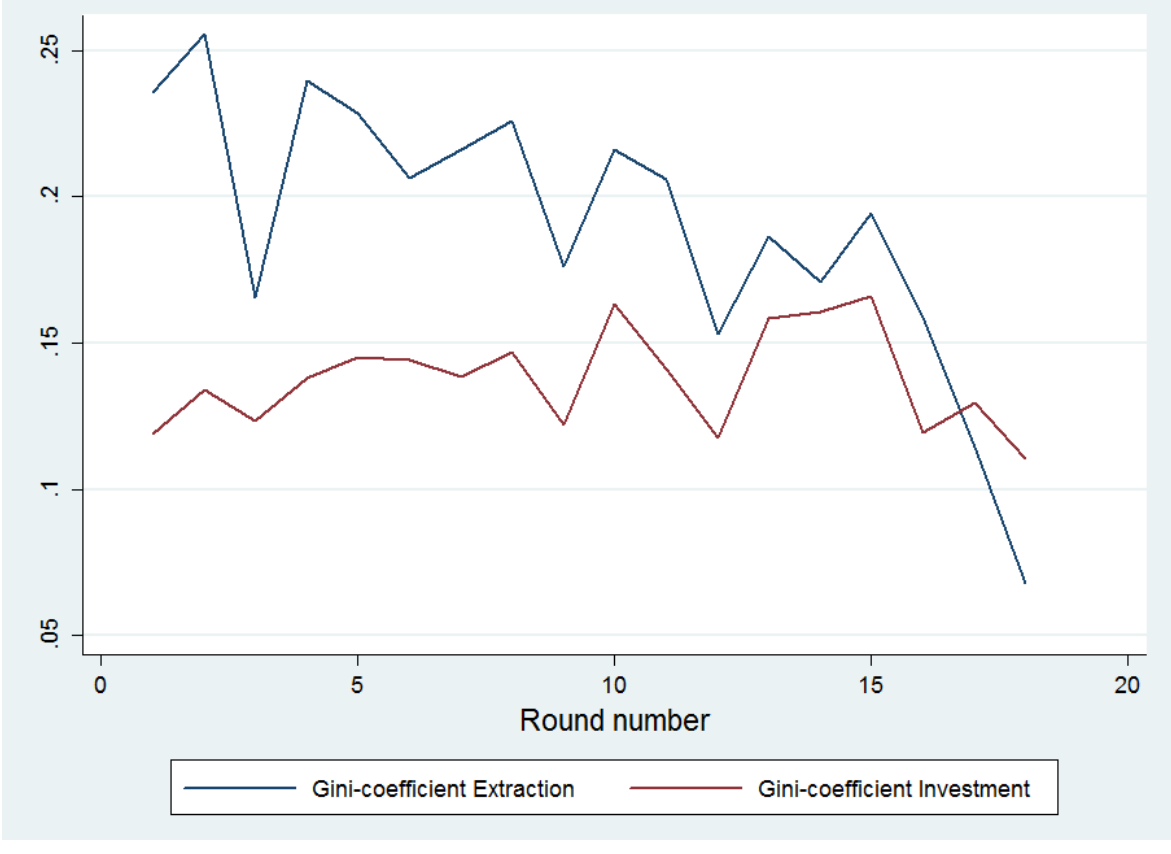
Table A5.1. Mixed effects regression models explaining Gini-coefficients of